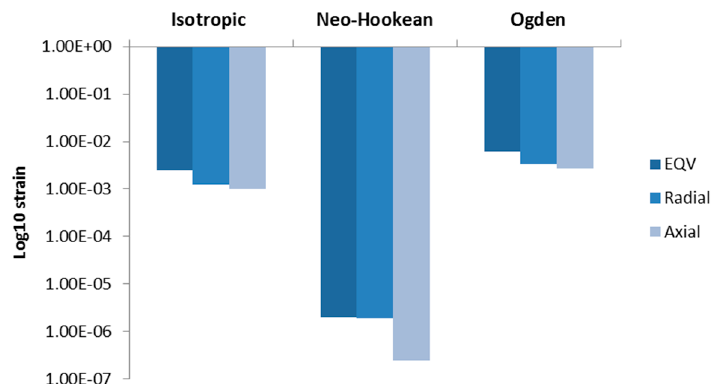
Figure 12. Comparison of maximum strains with different material model at peak expiration ( t = 0.5 s). The plot is log 10 plot to exaggerate the proportion of strains from Neo-Hookean material model.